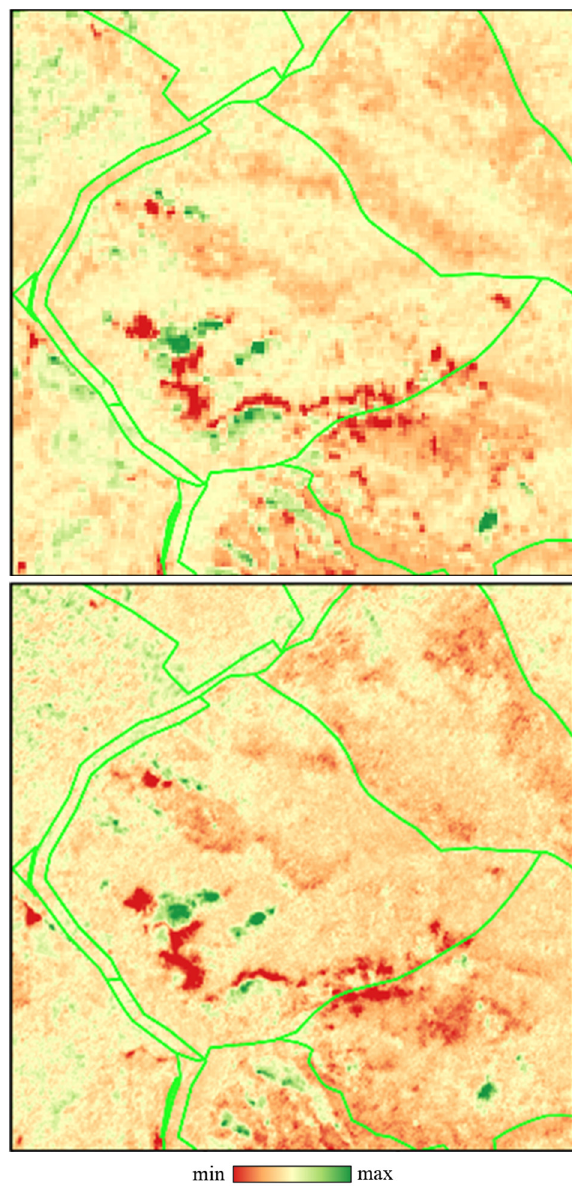
Figure 3. Automatically calculated ΔNDVI based composite for cloud- and shadow free 10-m S2 mosaic for 2016 and 2021 year (above) and corresponding PlanetScope ΔNDVI (below) in 3-m spatial resolution for forest compartment/subcompartment